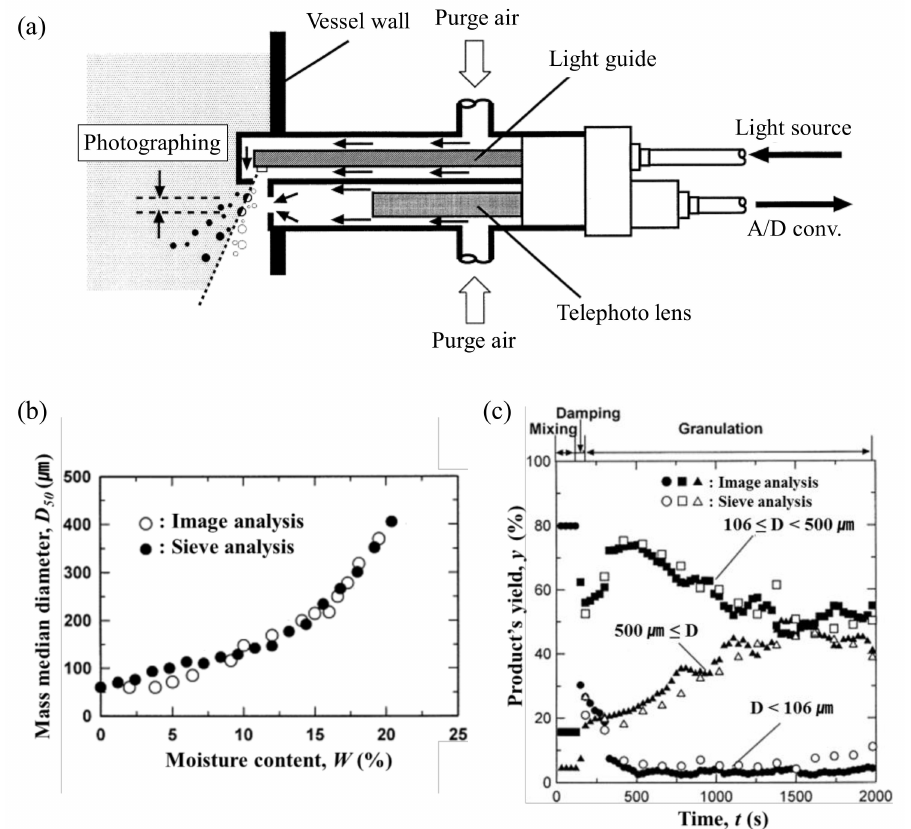
Figure 6. ( a ) Schematic diagram of image probe. A / D conv. is analog-to-digital converter; ( b ) the relationship between the moisture content and the median diameter of granules; ( c ) the results of yield for each granule size measured during the granulation process. Circles represent a particle size of less than 106 µ m, squares represent particle sizes of 160–500 µ m and triangles represent particle sizes of 500 µ m or more [39]. The figures were slightly modified, with permission from